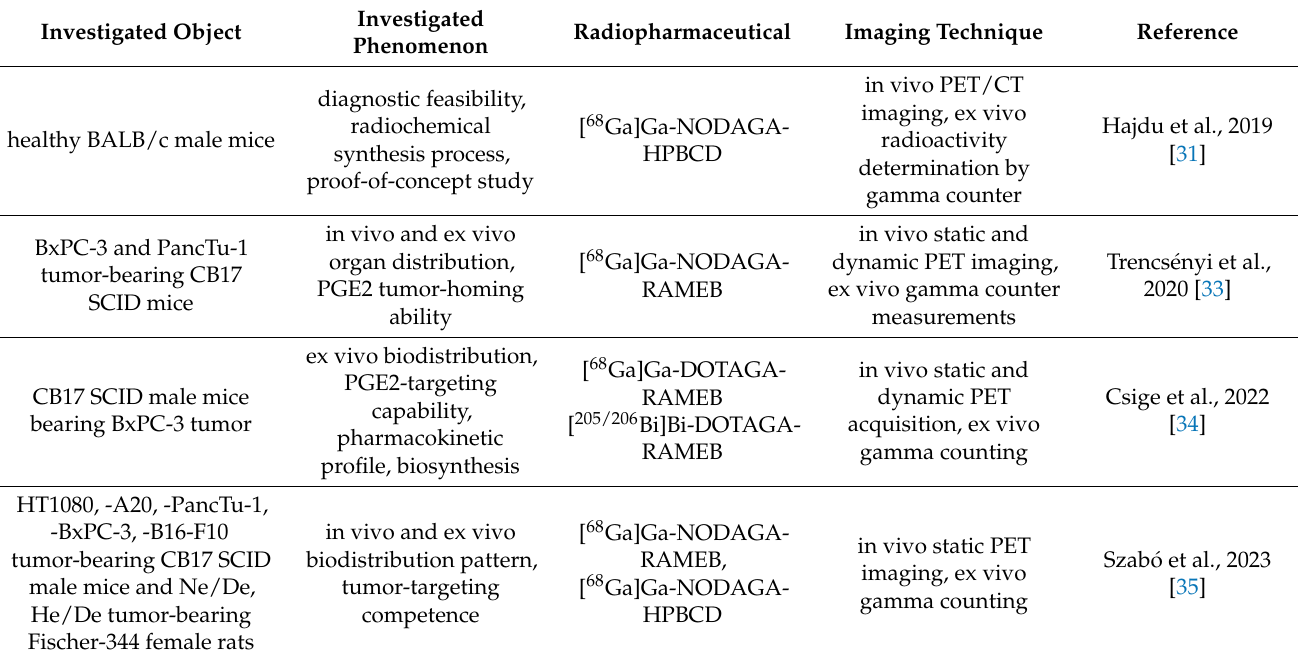
Table 1. Overview of preclinical studies with radiolabelled prostaglandin E2 (PGE2)-targeting cyclodextrins